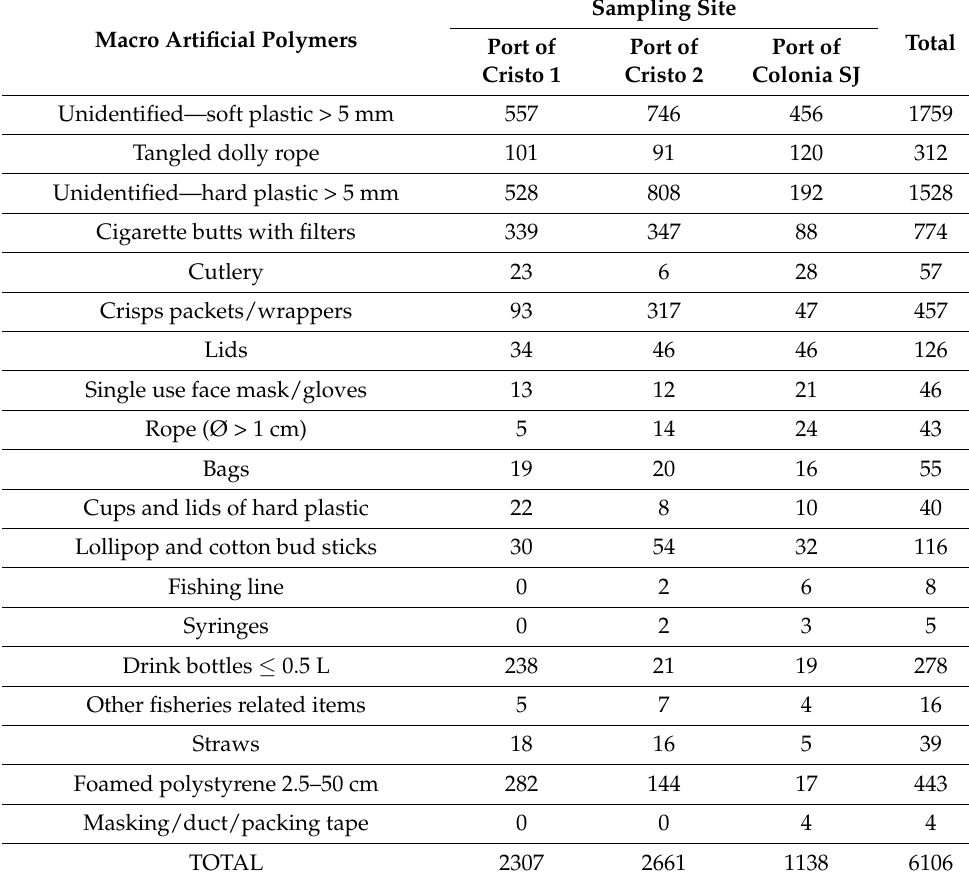
Table 2. Total number of collected Macro artificial polymer